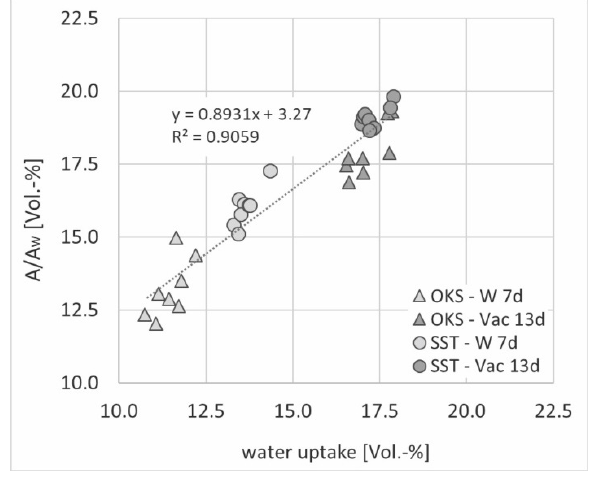
Figure 6. Correlation of gravimetric water uptake and measured NMR signal normalised to A w .